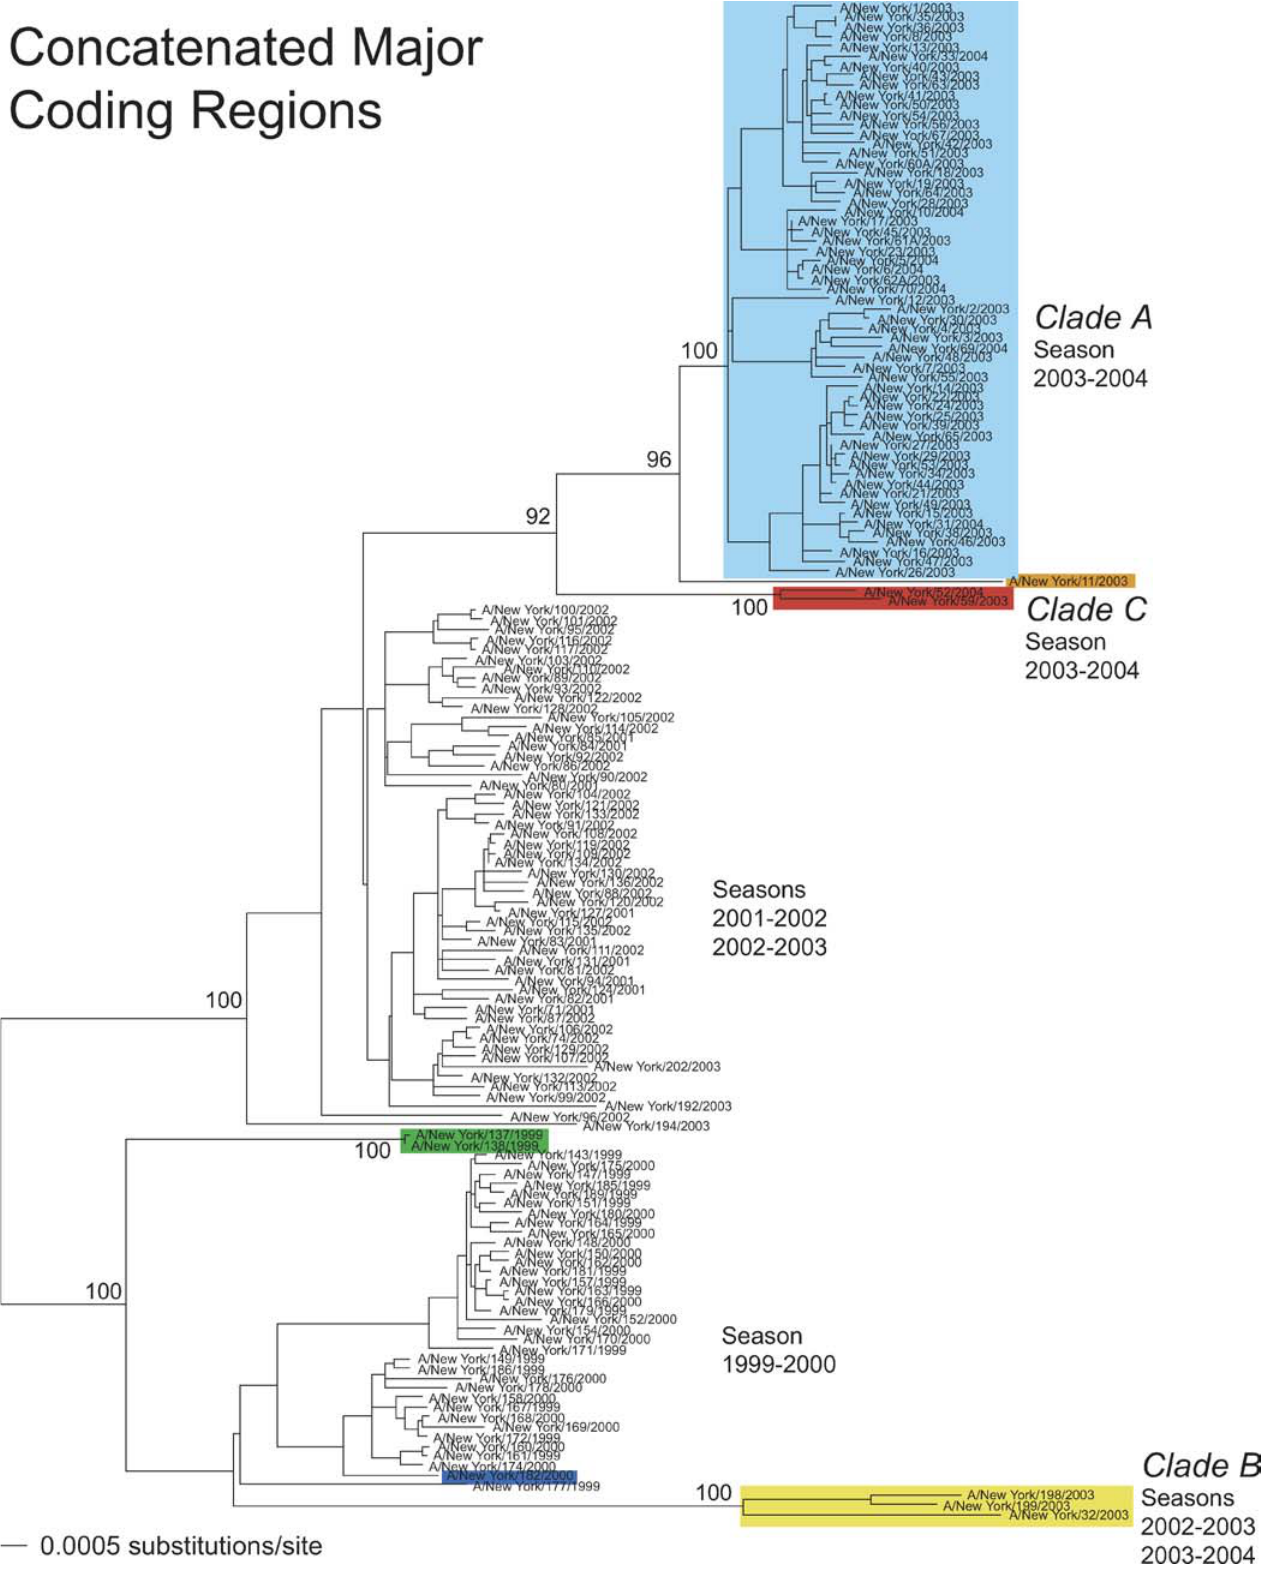
Figure 1. Evolutionary Relationships of Concatenated Major Coding Regions of Influenza A Viruses Sampled in New York State during 1999–2004 The maximum likelihood phylogenetic tree is mid-point rooted for purposes of clarity, and all horizontal branch lengths are drawn to scale. Bootstrap values are shown for key nodes. Isolates assigned to clade A (light blue), clade B (yellow), and clade C (red) are indicated, as are those isolates involved in otherreassortmentevents:A/NewYork/11/2003(orange),A/NewYork/182/2000(darkblue),andA/NewYork/137/1999andA/NewYork/138/1999(green). DOI: 10.1371/journal.pbio.0030300.g001 PLoS Biology |